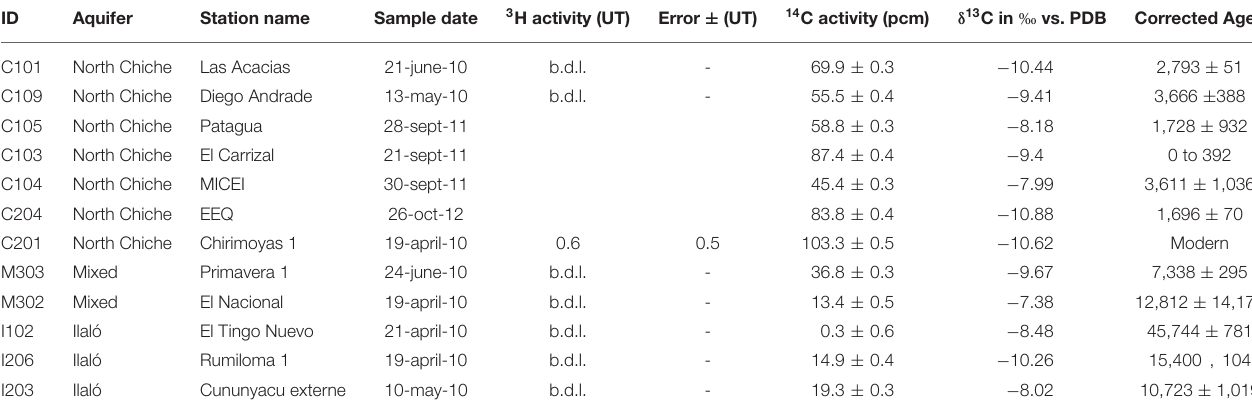
TABLE 1 | 3 H. 14 C and 13 C values in North Chiche aquifer and Ilaló aquifer, b.d.l. below detection